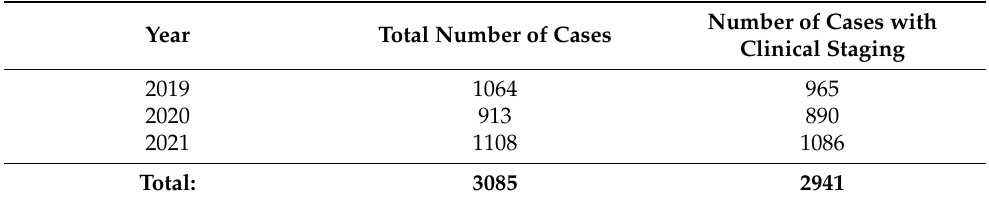
Table 1. Total number of BC cases reviewed by the MDT team in 2019–2021. Year Total Number of Cases